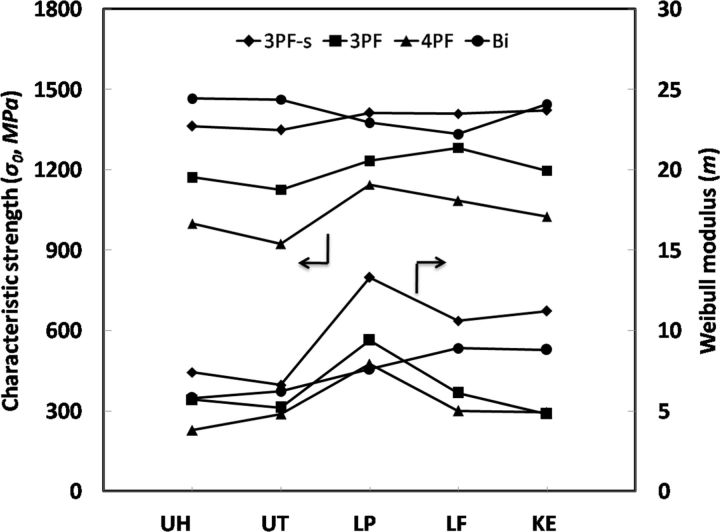
Characteristic strength (σ0, MPa) and Weibull modulus (m) of five ceramics (UH, UT, LP, LE and KE) tested by 3PF-s, 3PF 4PF and BI.